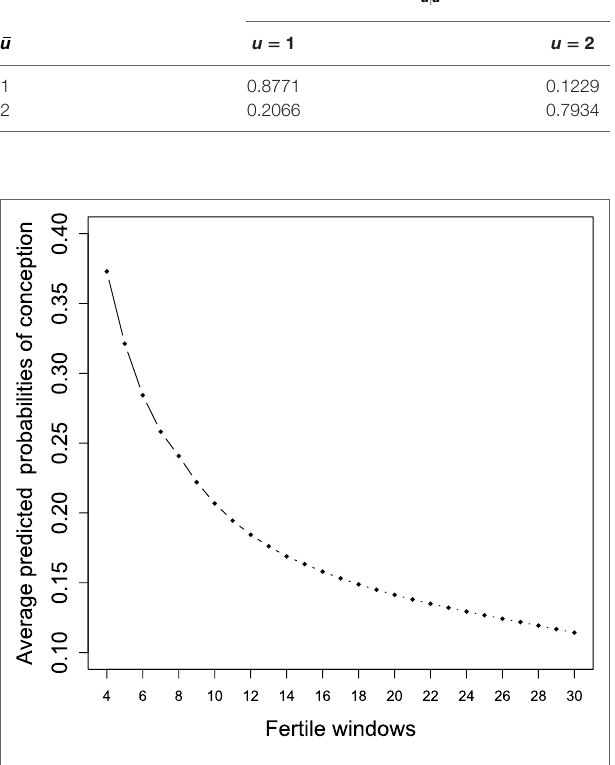
FigUre 1 | Average predicted probabilities of conception (state 2) in accordance with the LM model estimated for an increasing number of fertile windows.